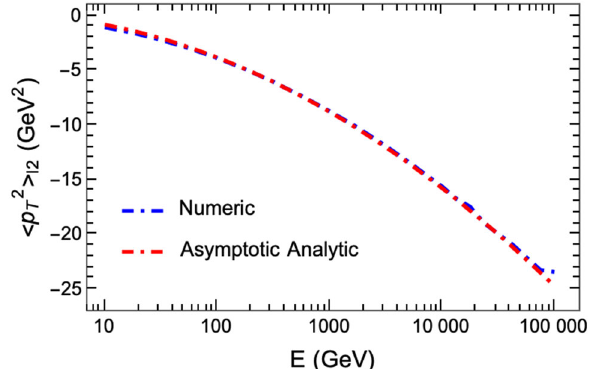
Fig. 14 Comparison between the full numerical (cid:2) p 2 ⊥ (cid:4) I 2 from Eq. (44) to the approximation Eq. (51) for L = 5 fm and μ = 0 . 5 GeV with the overall factor of C R α s L /π 2 λ